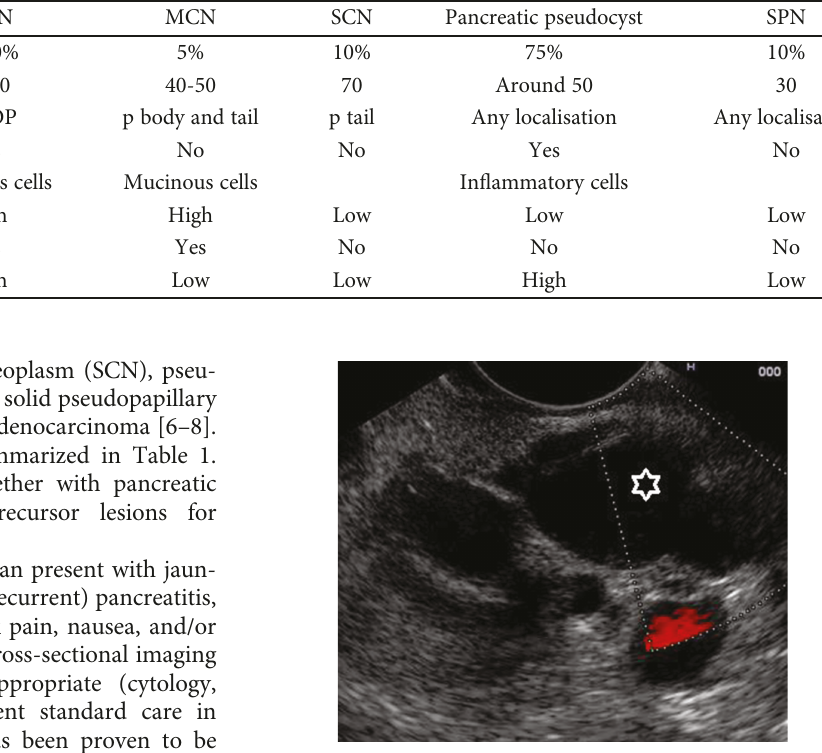
Figure 1: Main duct intraductal papillary mucinous neoplasia (asterisk: dilatation of the main pancreatic duct).